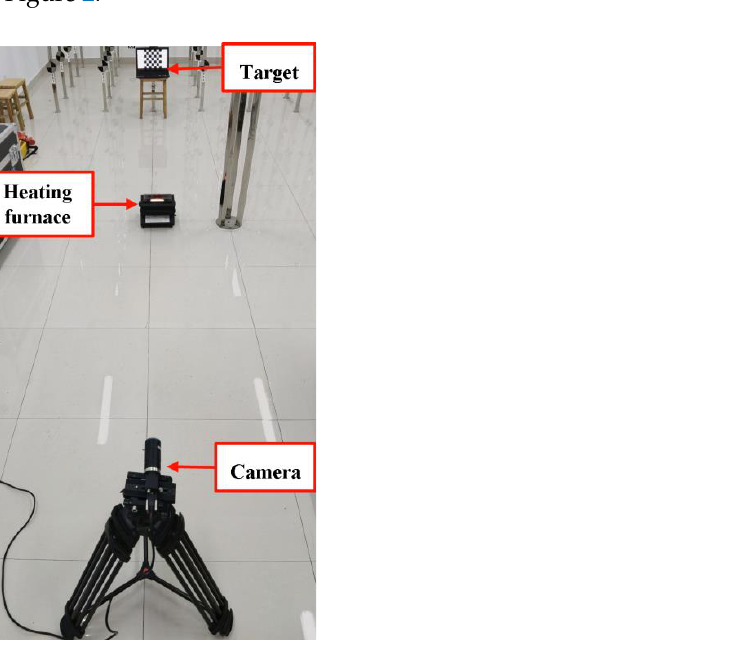
( d ) Figure 4. Displacement measurement results before and after optical-turbulence error mitigation. Number of measurement points ( a ) 1, ( b ) 36, ( c ) 256, ( d ) 484.